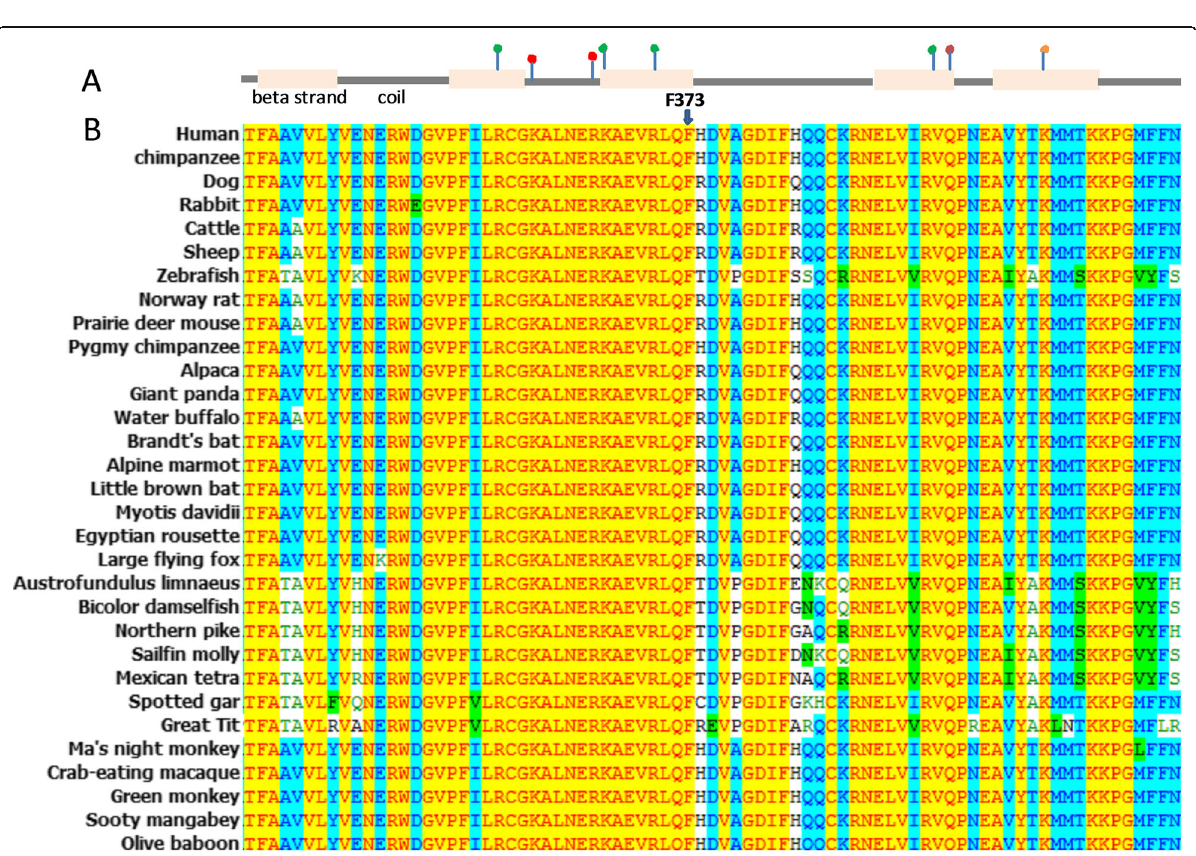
Fig. 4 Evolutionary conservation of identified G6PD missense variant. a As shown, the second structure and p.Phe373 are located at the end of the beta strand, the green dot depicts the NADP binding site, the orange dot shows the N6-acetyllysine modified residue, and the red dot shows the substrate binding site. b G6PD sequences from different species were aligned using the Clustal Omega in order to investigate the evolutionary conservation of the phenylalanine residue located in the codon. The multiple alignments revealed total conservation of this residue across all species, suggesting that this residue is crucial for the protein